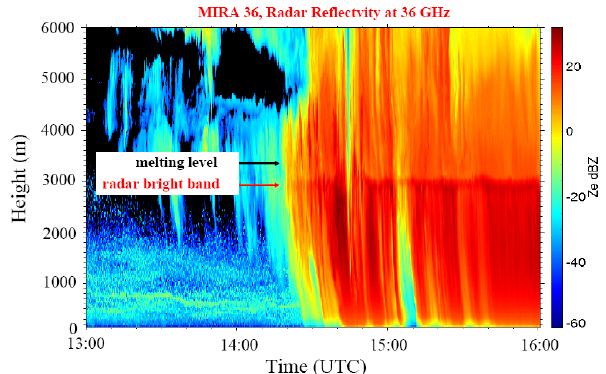
783 Figure 5. Time evolution of the linear depolarization ratio at 35.5 GHz from 13:00 UTC to 784 16:00 UTC on 23 July 2007 as measured by MIRA 36 . 785 Fig. 5. Time evolution of the linear depolarization ratio at 35.5GHz from 13:00UTC to 16:00UTC on 23 July 2007 as measured by MIRA 36. Arrows indicate the location of the melting level and the radar bright band. 786